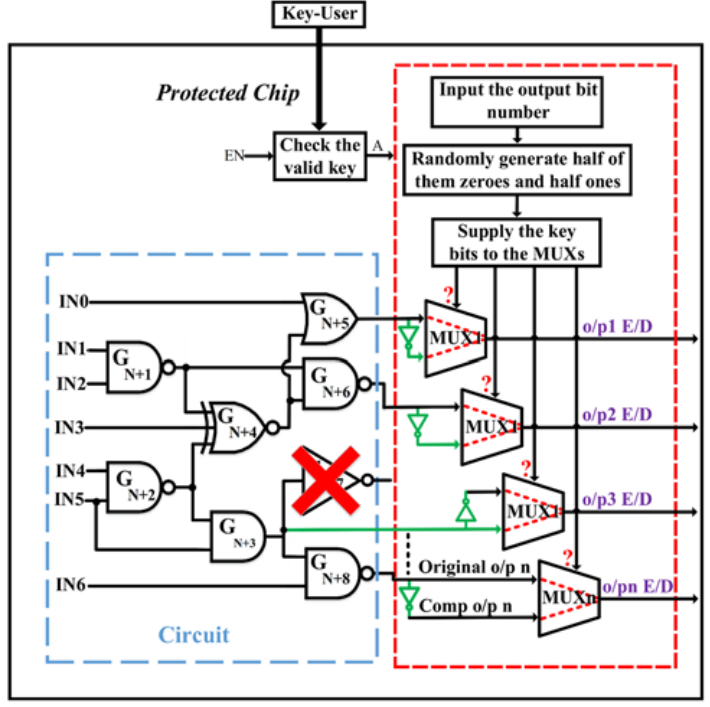
Figure 35. Logic encryption based on full Multiplexer (MUX) insertions.